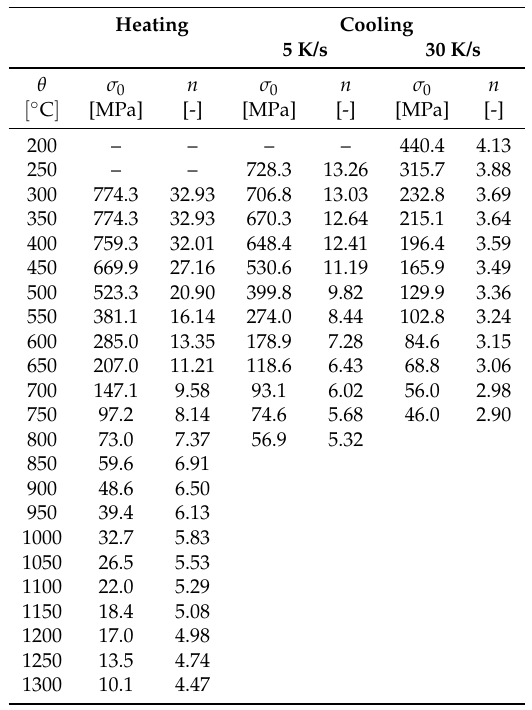
Table 4. Determined flow properties for ˙ ε 0 = 0.001 s − 1 .